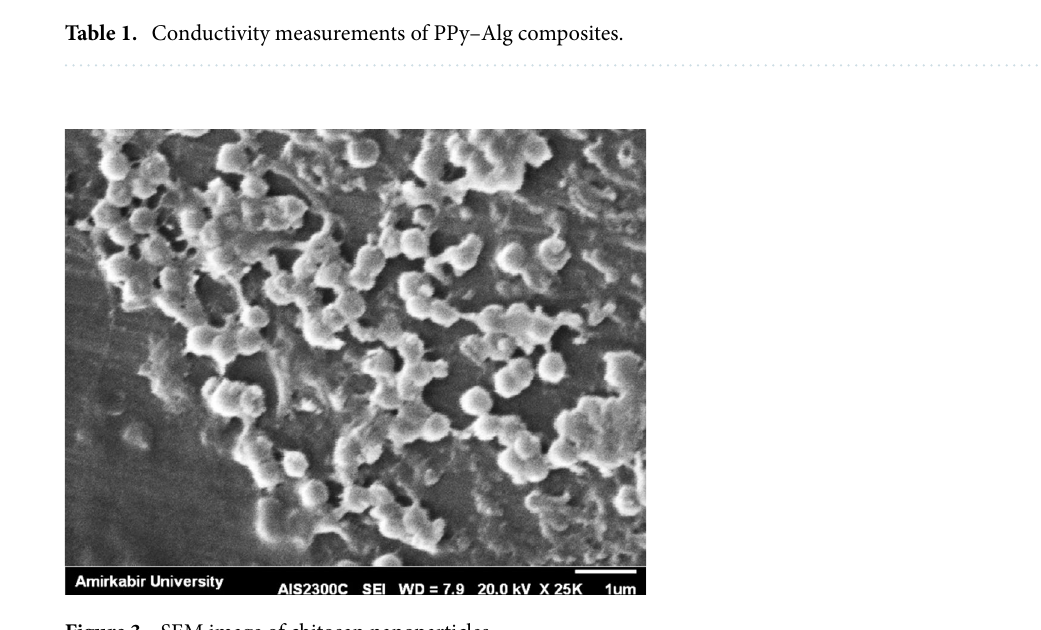
Figure 3. SEM image of chitosan